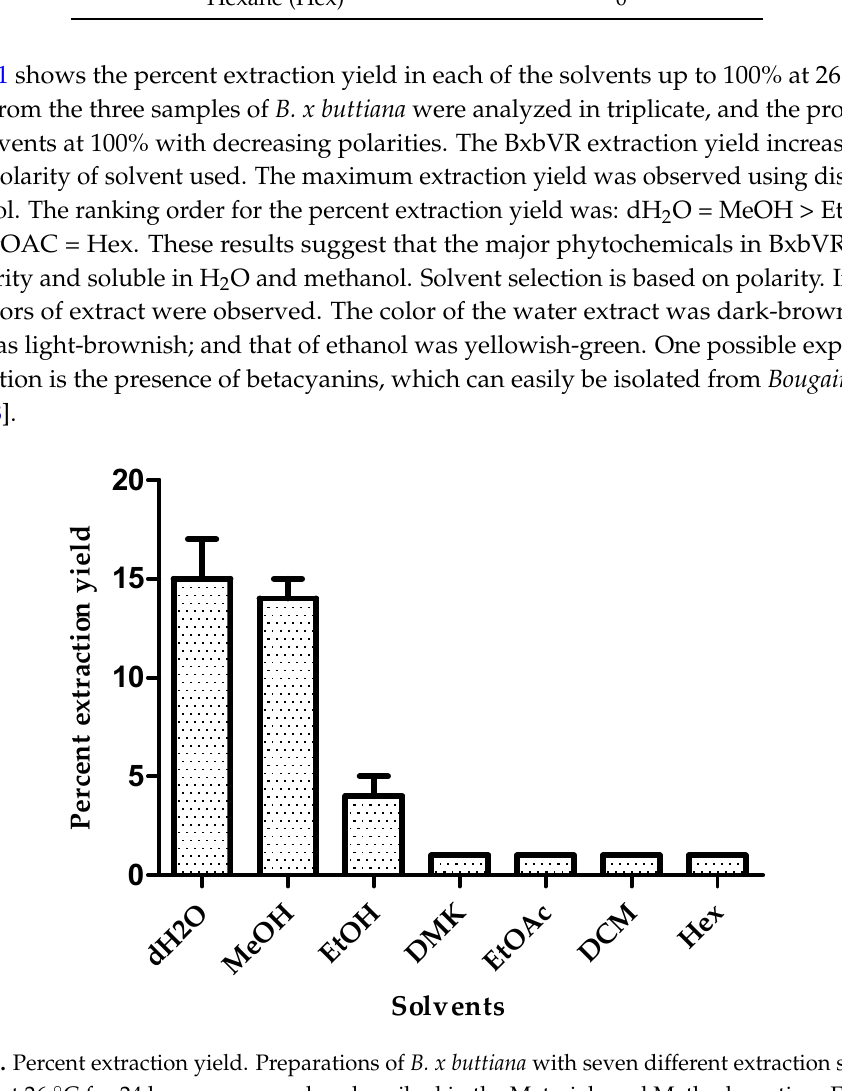
Table 1. Polarity index (Snyder [27]).